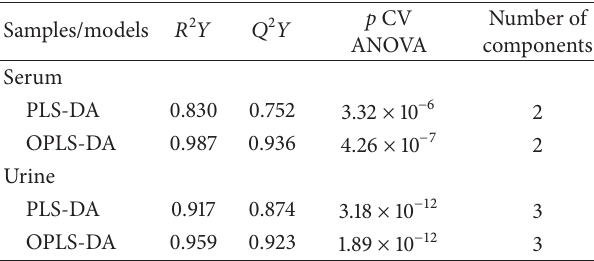
Table 3: PLSDA and OPLS-DA models validation for serum and urine of Sprague-Dawley rats fed a high fat diet (HFD) or a normal diet (ND) for 12